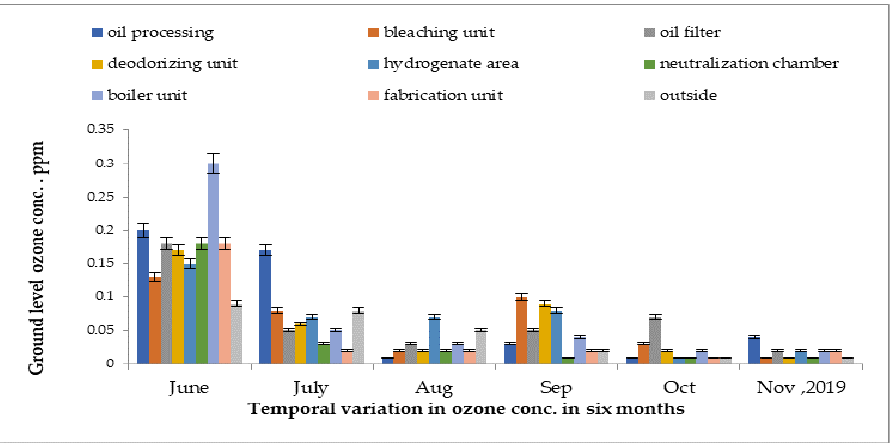
Figure 8. Variations in indoor and outdoor ground-level ozone concentrations in different units of oil industry from June 2019 to November 2019.